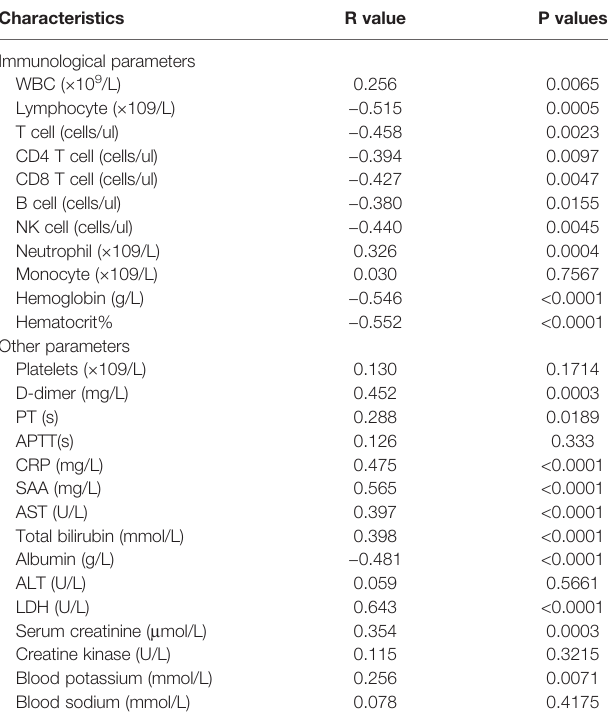
TABLE 1 | Correlations between CD38 hi HLA-DR + percentage and parameters in COVID-19 patients. Characteristics R